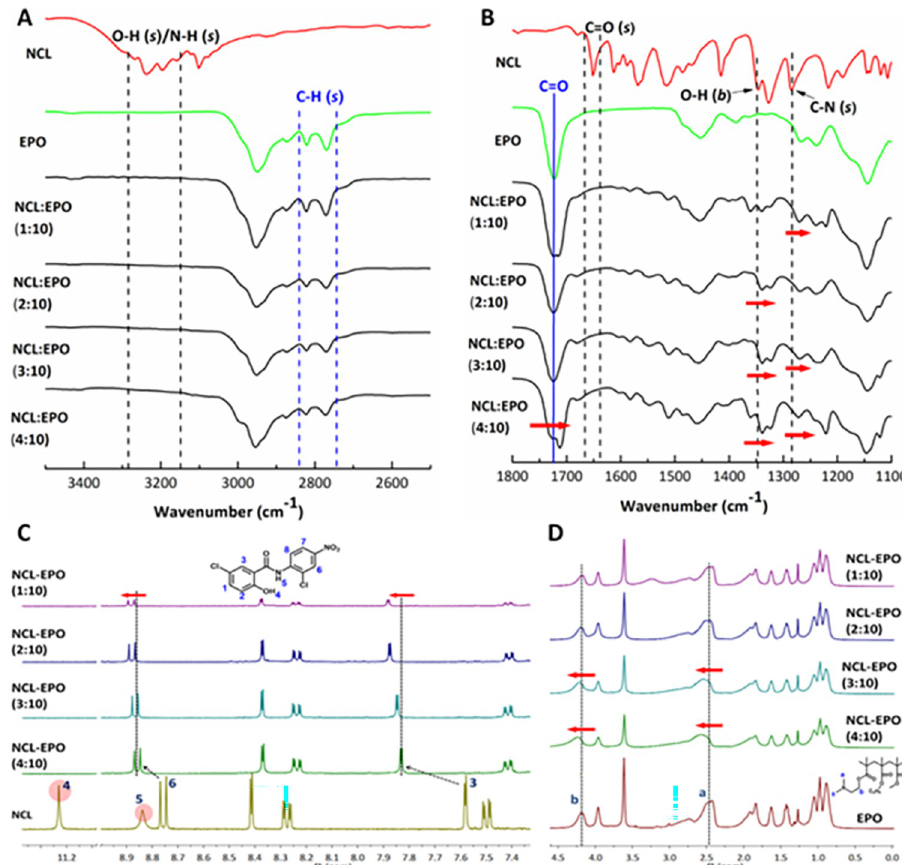
Fig 1. NCL interacts with Eudragit EPO at a molecular level, and the concentration of NCL relative to EPO impacts the extent of molecular interaction. Solid dispersion containing different weight ratios of NCL and